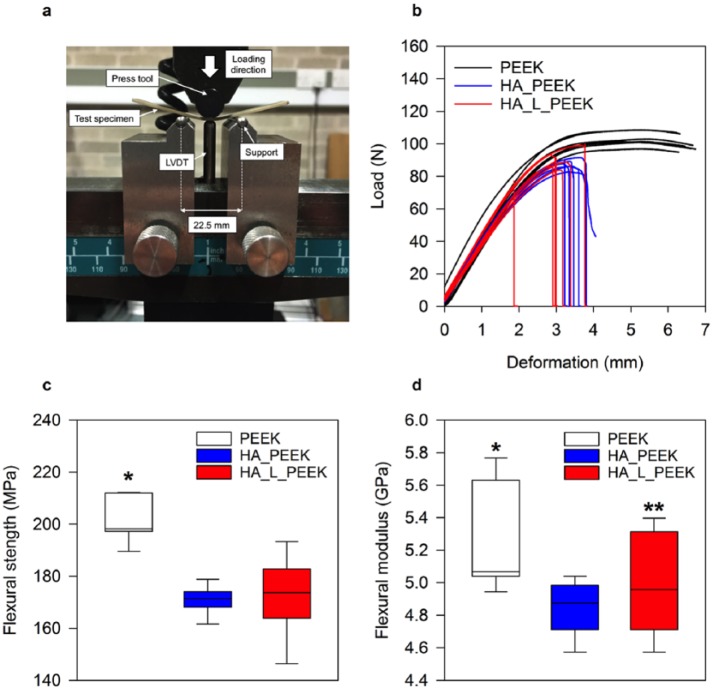
Mechanical properties of PEEK, HA_PEEK and HA_L_PEEK materials. (a) 3-point bend test set-up (LVDT: linear variable displacement transducer). (b) Load–displacement curves for PEEK, HA_PEEK and HA_L_PEEK materials. (c) Flexural strength box-plots for all groups calculated from the load–displacement curves in (b) (n = 7) (*p < 0.05 for PEEK vs HA_PEEK and for PEEK vs HA_L_PEEK). (d) Flexural modulus box-plot for all groups calculated from the load–displacement curves in (b) (n = 7) (*p < 0.05 for PEEK vs HA_PEEK, **p > 0.05 for PEEK vs HA_L_PEEK).